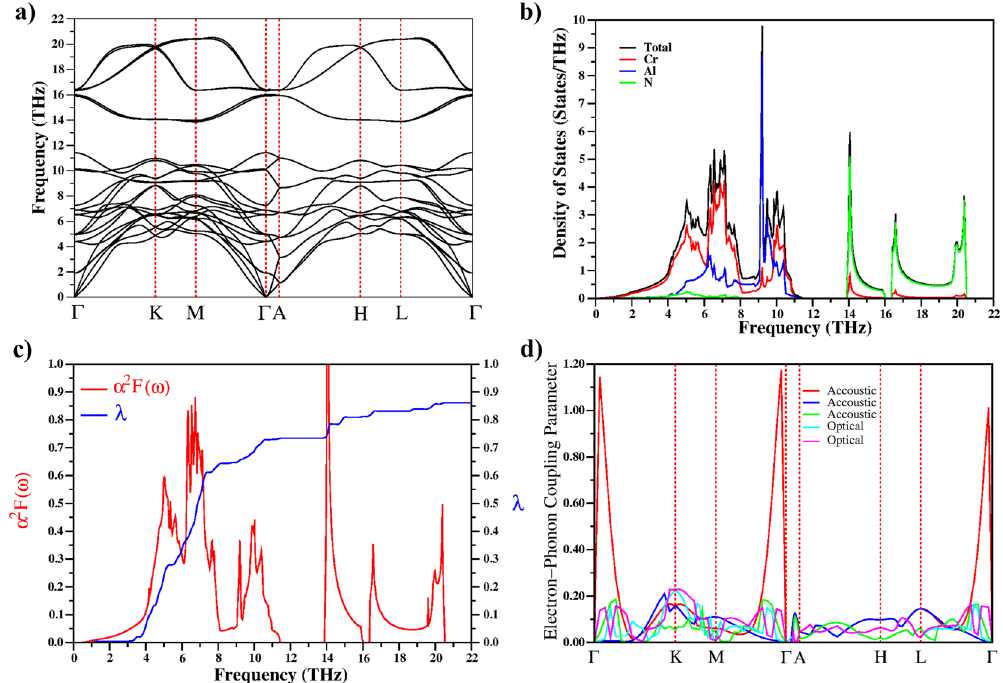
2 F (ω) (red line) and the variation